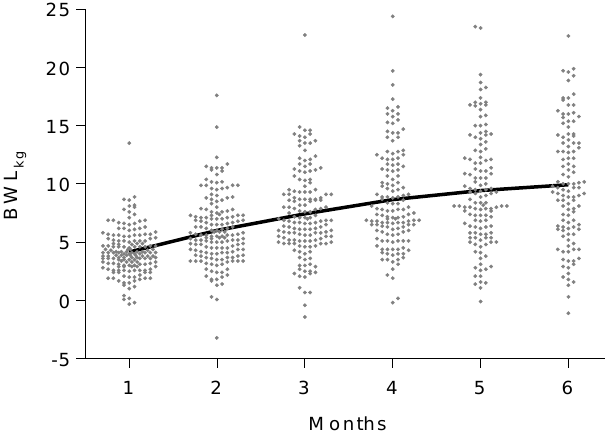
Figure 1. Variability in the body weight loss in kilograms (BWL kg ) for every time point in the 6-month follow-up period, induced by 30 mg phentermine in 166 patients with obesity. Each point represents the weight loss by one subject for any given month, whereas the line shows the trend of average weight loss for every month. BWL kg = Body weight loss in kilograms. Table 2. Anthropometric and cardiometabolic changes induced by 30 mg phentermine in subjects who completed at least 3 months of